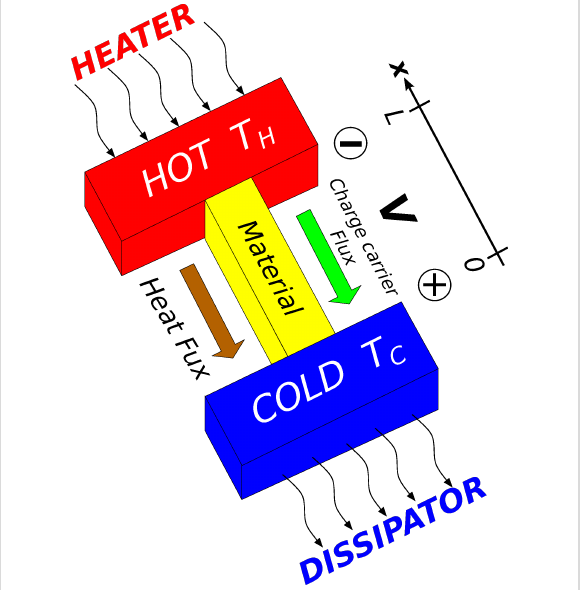
Figure 1: Sketch of a piece of semiconducting material, placed between a hot source (heater, temperature T H ) and a cold source (heat sink, temperature T C ). A potential difference V is established between the extremities, due to the charge carrier flux driven by the temperature gradient.